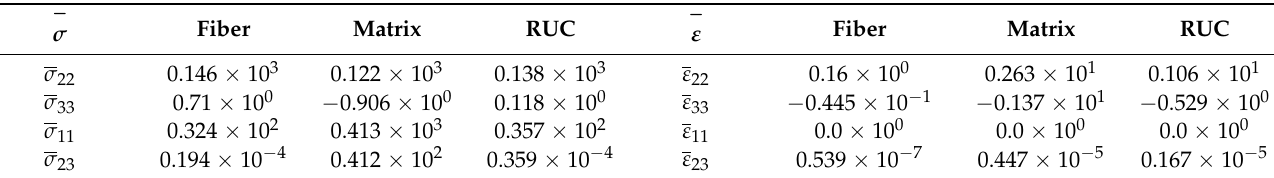
Table 1. Average values of stress and strain (Case 1).